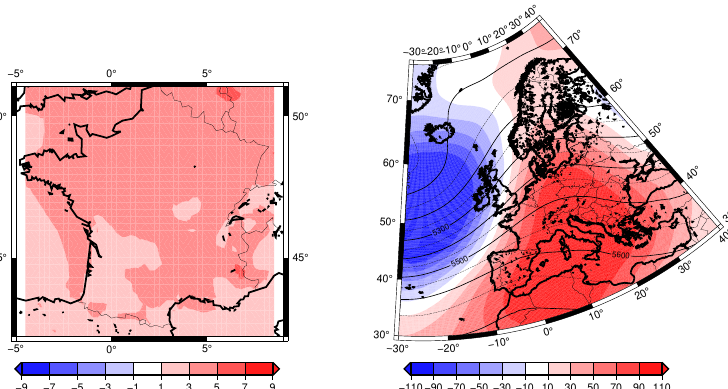
Figure 4. Left panel : mean anomalies of T2m (in K) over France between 1 December 2015 and 13 January 2016. Right panel : mean anomalies of Z500 (in m) over the East North Atlantic region (colours). Contour lines indicate the mean Z500 (in m).